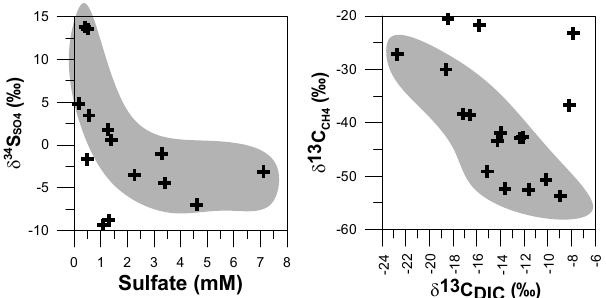
Figure 12. δ 34 S vs. sulfate concentrations and δ 13 C of methane vs. DIC for samples in category no. 3 supporting that methane ox- idation coupled with bacterial sulfate reduction is responsible for elevated δ 13 C values of methane.